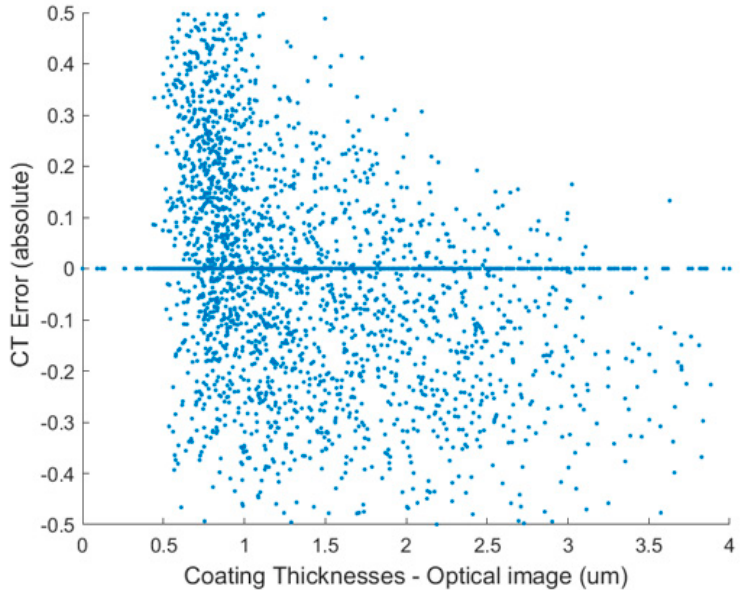
Figure A3. Absolute error in the fiber coating thickness correlation (CT-Optical)/Optical.